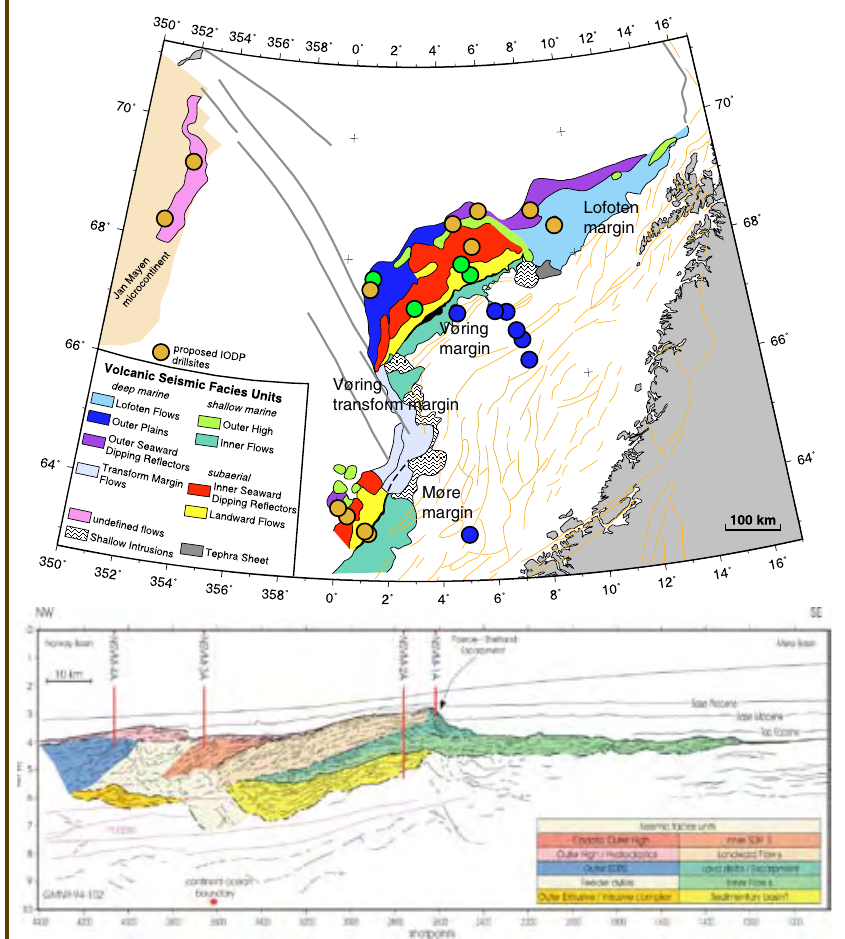
Figure 7. Upper: Distribution of volcanic seismic facies units on the mid-Norwegian margin (from Berndt et al., 2001), proposed IODP sites, and selected boreholes (DSDP/ODP drill sites in green circles; commercial boreholes in blue circles). Lower: Interpreted seismic profile across the Møre Margin (location above), revealing several distinct volcanic facies units (Planke and Alvestad, 1999; Planke et al.,